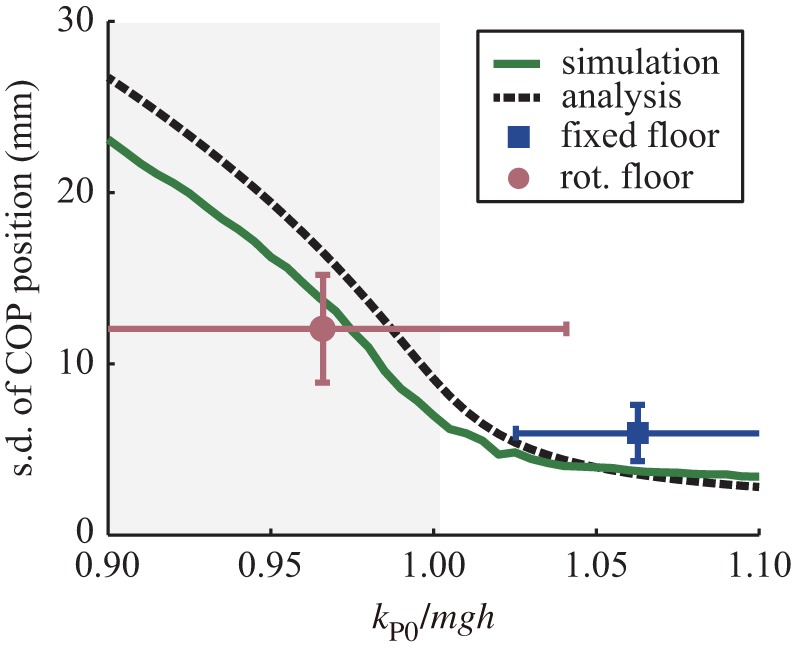
Comparison of the characteristics of control gain and sway amplitude (s.d. of COP) of the model and experimental results. Blue and red points are the means of the results for fixed and rotational floors, respectively. Lines around the points show the s.d. of the gain and sway amplitude.